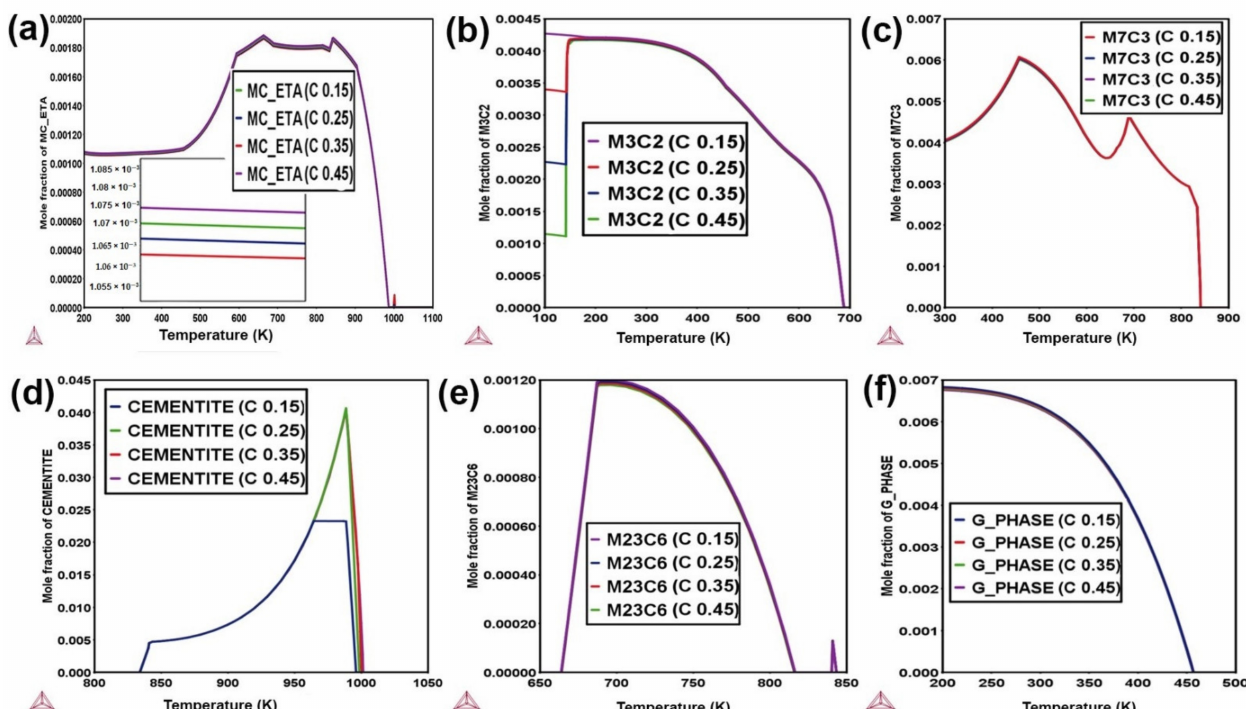
Figure 2. Effect of C concentration to MS1 alloys for, ( a ) MC_ETA; ( b ) M 3 C 2 ; ( c ) M 7 C 3 ; ( d ) cementite; ( e ) M 23 C 6 ; ( f )